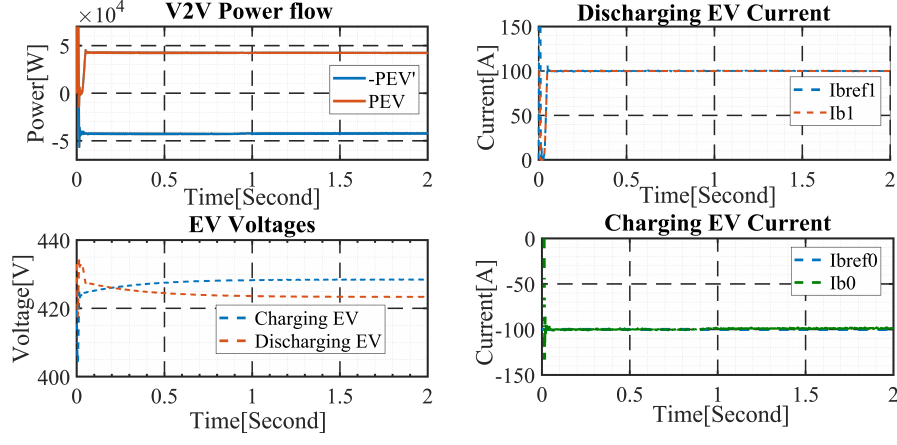
Figure 26. Illustration of V2V process in the